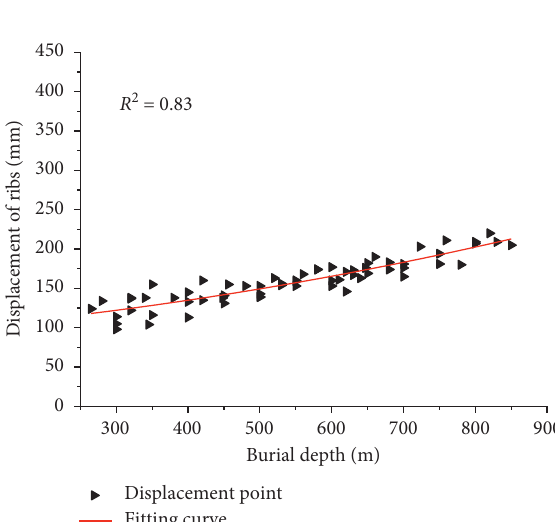
Figure 23: 80m away from the working face.